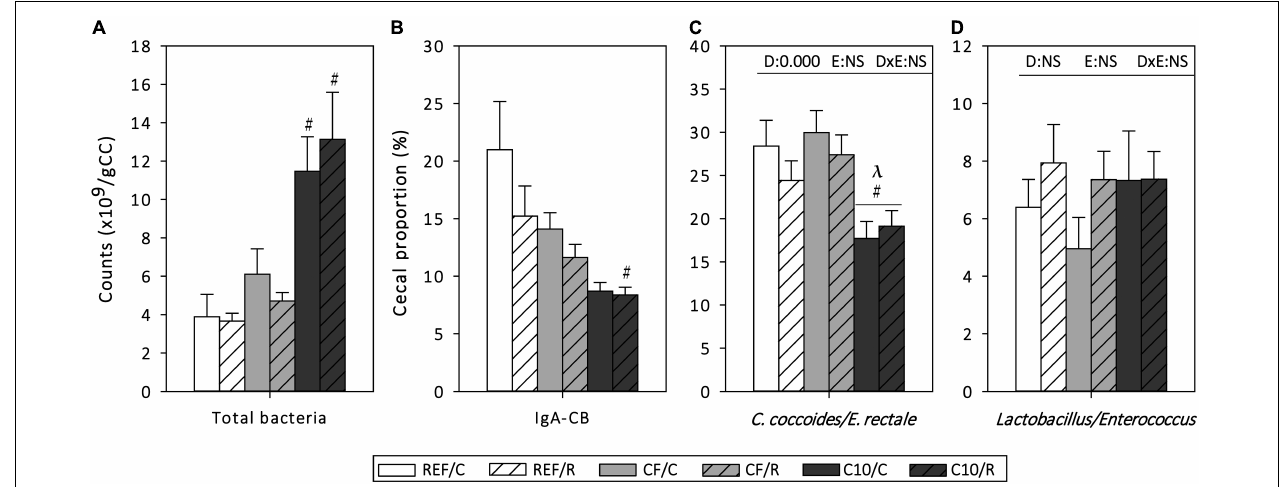
FIGURE 3 | Cecal microbiota composition: counts of total bacteria (A) , proportion of IgA-coated bacteria (B) , and proportions of Clostridium coccoides/Eubacterium rectale (C) and Lactobacillus/Enterococcus (D) in cecal content homogenates. The control (C) groups are represented by smooth bars and the runner (R) groups by striped bars. REF, reference diet; CF, 5% cocoa fiber-enriched diet; C10, 10% cocoa-enriched diet; NS, no statistically significant differences detected. Data are expressed as mean ± SEM ( n = 8). Statistical differences (Kruskal-Wallis followed by Dunnet’s test): # p < 0.05 vs. the same exercise condition in the REF diet; λ p < 0.05 vs. the same exercise condition in the CF diet. The inset table shows two-way ANOVA results when applied (D, diet; E, exercise, DxE, interaction between diet and